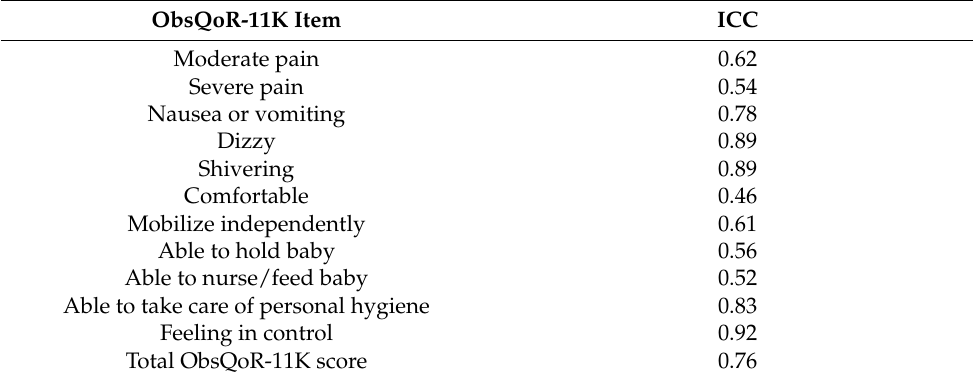
Table 5. Intraclass correlation coefficient (ICC) for ObsQoR-11K items. ObsQoR-11K Item ICC Moderate